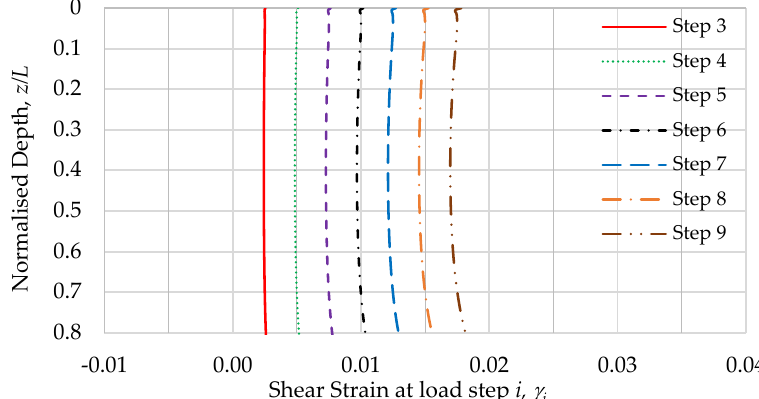
Figure 8. Normalized depth versus shear strain, from FE analysis.